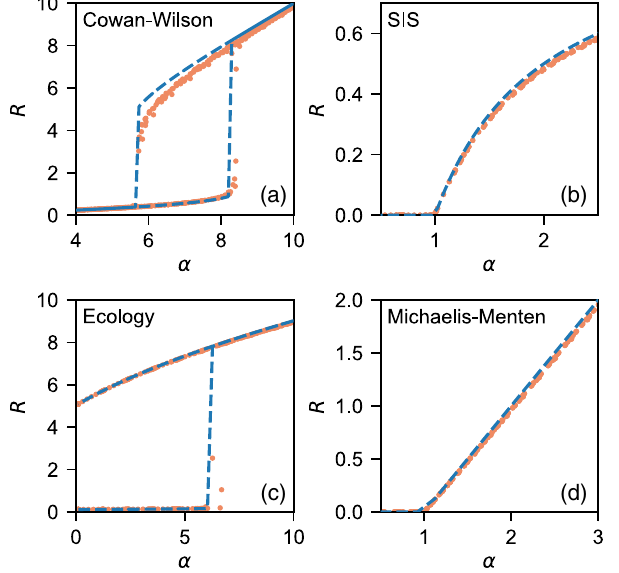
FIG. 2. (a) Comparison of the observable R (cid:3) ¼ a T x (cid:3) at equi- FIG. 1. Observable R (cid:3) ¼ a T x (cid:3) at equilibrium as a function of librium as a function of the dominant eigenvalue α of W T for the dominant eigenvalue α of W T , for different dynamics on different connection probabilities p of undirected Erd ő s-R´enyi Erd ő s-R´enyi networks of N ¼ 100 nodes and connection prob- networks G ð N; p Þ and the Cowan-Wilson dynamics [Eq. (2a)] ability p ¼ 0 . 1 . (a) Cowan-Wilson dynamics [Eq. (2a)] with with τ ¼ 1 , μ ¼ 3 . For each value of p , 10 networks of 200 nodes τ ¼ 1 , μ ¼ 3 , (b) SIS dynamics [Eq. (2e)] with γ ¼ 1 , (c) mutu- are generated, and their dynamics are solved for α ∈ ½ 4 ; 10 (cid:2) . Lines alistic ecological dynamics [Eq. (2c)] with B i ¼ 0 . 1 ; C i ¼ are computed as a binned average over networks sharing the same 1 ; K 5 ; D 6 ; E 0 . 9 ; H 0 . 1 [20], and (d) Michae- i ¼ i ¼ i ¼ i ¼ probability of connection. (b) Comparison of Erd ő s-R´enyi net- lis-Menten dynamics [Eq. (2d)] with a ¼ 1 , b ¼ 1 , c ¼ 1 . works G ð N; p Þ of different sizes N ∈ f 20 ; 100 ; 500 g but equal Dashed lines are theoretical predictions obtained from Eq. (9), average numbers of edges per node h k in B i ¼ 10 . For each N , we while dots are equilibrium states resulting from the evolution of adjust the connection probabilities p ∈ f 0 . 50 ; 0 . 10 ; 0 . 02 g to the whole N -dimensional system. For each dynamics and net- match the expected value of h k in B i and solve the dynamics on work ensemble, 100 networks are generated. For each network, 10 network realizations. Lines are computed as a binned average we scale the edge weights by a constant random factor as over same-size networks. Dashed lines are theoretical predictions w ↦ cw ij ij , so the dominant eigenvalue of the adjacency matrix obtained from Eq. (9). To obtain a specific α ¼ a T k in , we is located in the region of interest. Then, the dynamics is multiply each edge weight by a constant scaling factor w ij ↦ integrated to equilibrium, and an orange dot is placed at the cw α ↦ c α falls in the range corresponding point ð α ; R (cid:3) Þ . Next, the network is perturbed by ij so that the dominant eigenvalue [4,10] using the dominant eigenvector a as a weight vector. We removing an edge, the dynamics is brought back to equilibrium, then solve the dynamics at equilibrium and measure the observ- and a new dot is placed at ð α 0 ; R 0(cid:3) Þ . The perturbation step is able R (cid:3) ¼ a T x (cid:3) repeated 50 times for each network.